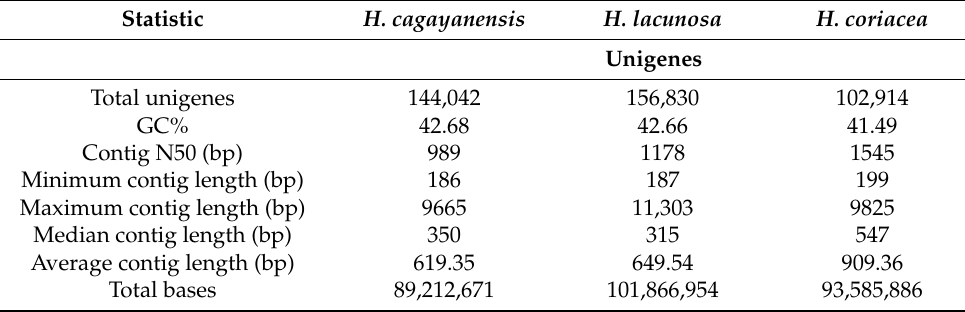
Table 3. Statistical summary of transcriptome assemblages for all species.